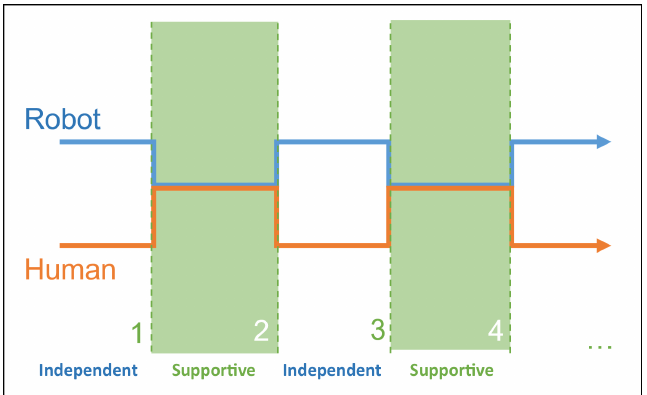
Figure 1. Collaboration